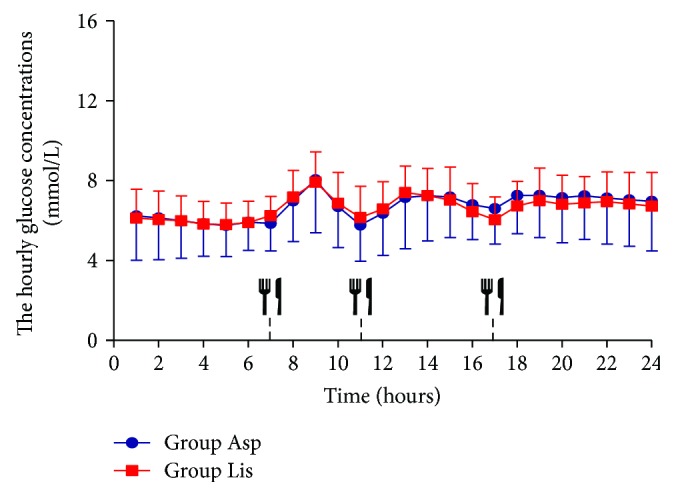
The glucose concentration per hour for 24 h by CGMS in group Asp and group Lis. The hourly glucose concentrations calculated from CGM. The hourly glucose concentrations in group Asp and group Lis. Data are presented as means ± SD. A two-way ANOVA was used in the comparison between groups. Participants were provided a standard breakfast (07:00 h), lunch (11:00 h), and dinner (17:00 h), to eat throughout the 3-day testing period.